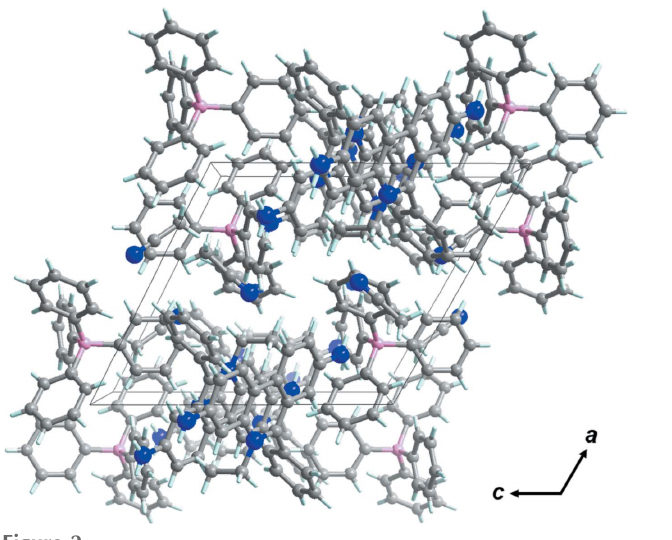
Figure 2 Packing of the title compound viewed along the b- axis direction.